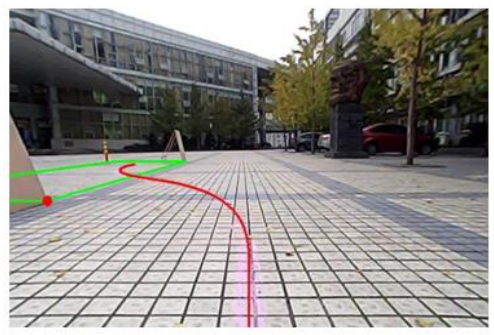
Figure 19. Parking space matching and trajectory generation.